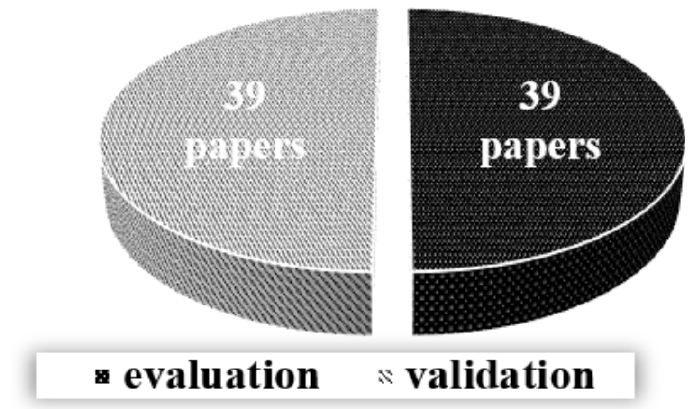
Figure 9. Presence of research types.